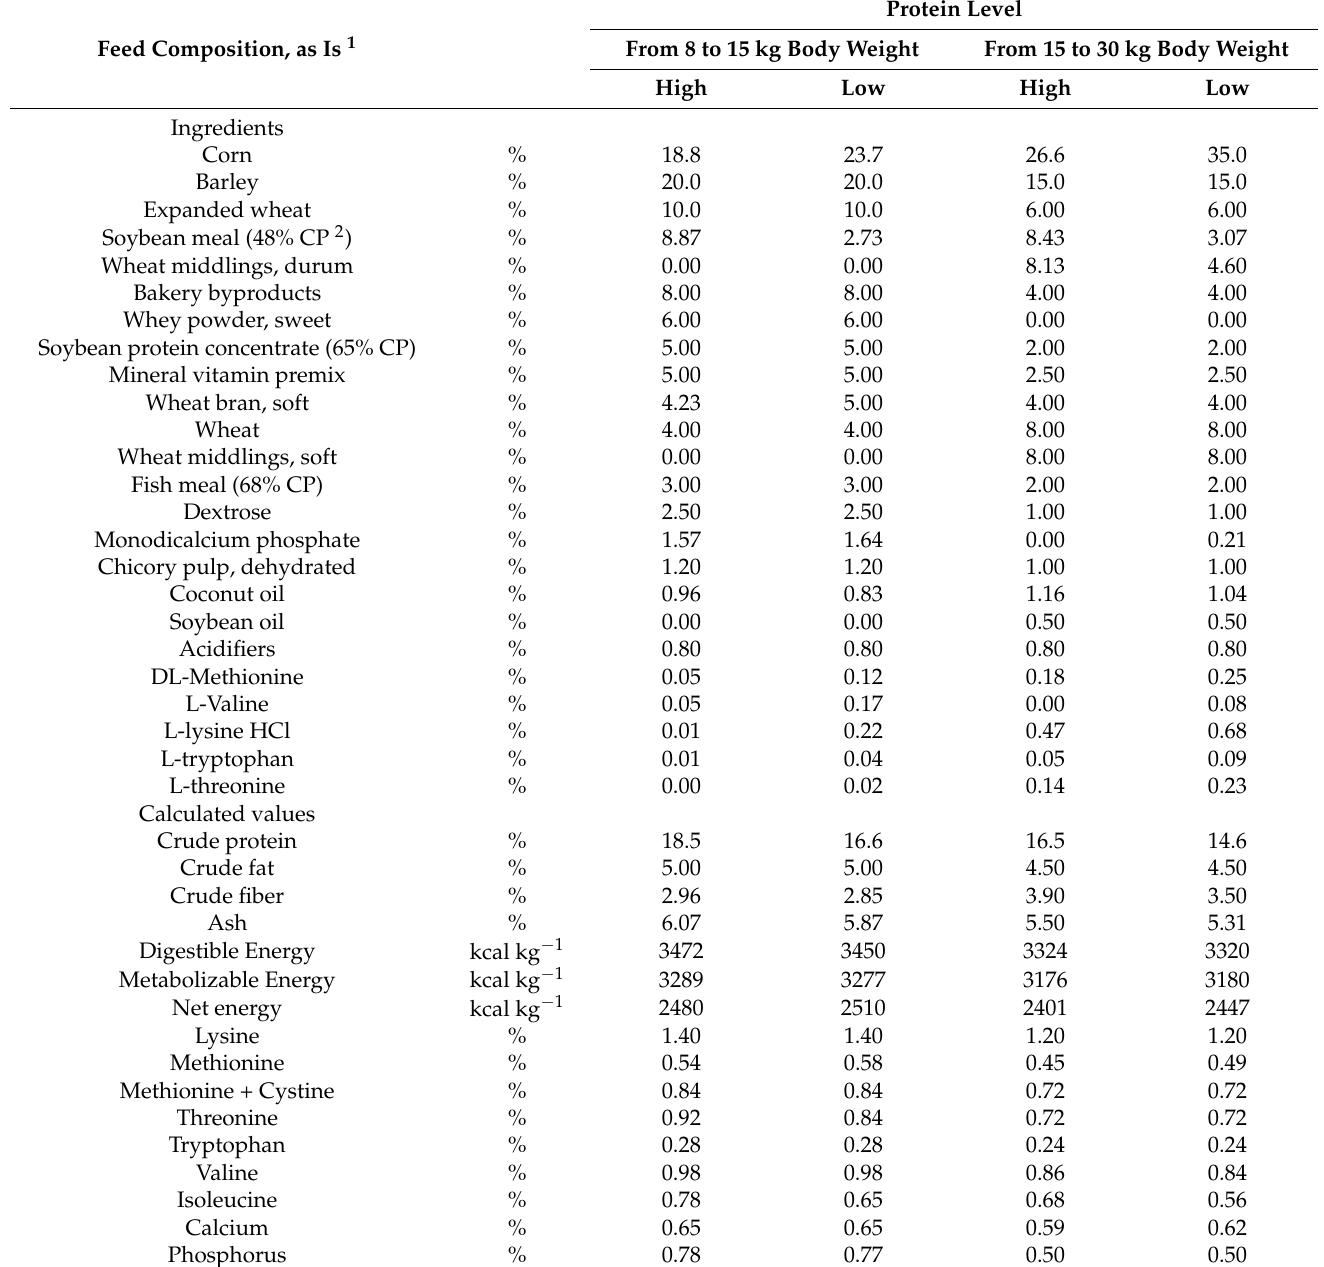
Table 3. Feed ingredients, depending on the growth phase and dietary protein